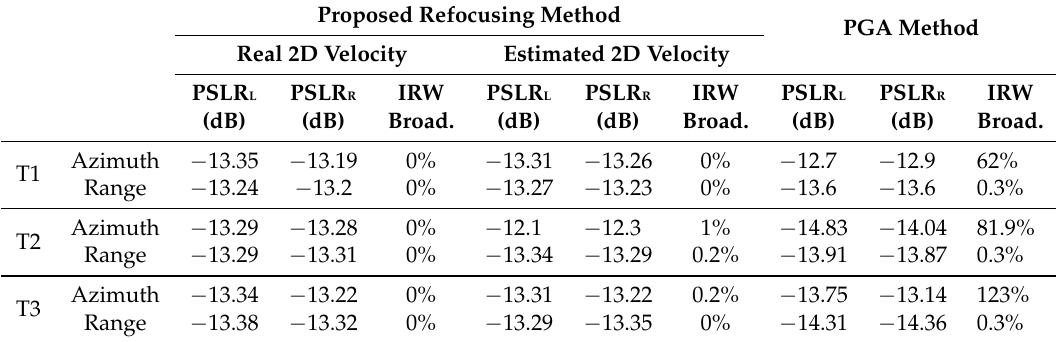
Table 3. Measured image quality parameters. PSLR L , left peak sidelobe ratio; PSLR R , right PSLR; IRW, impulse response